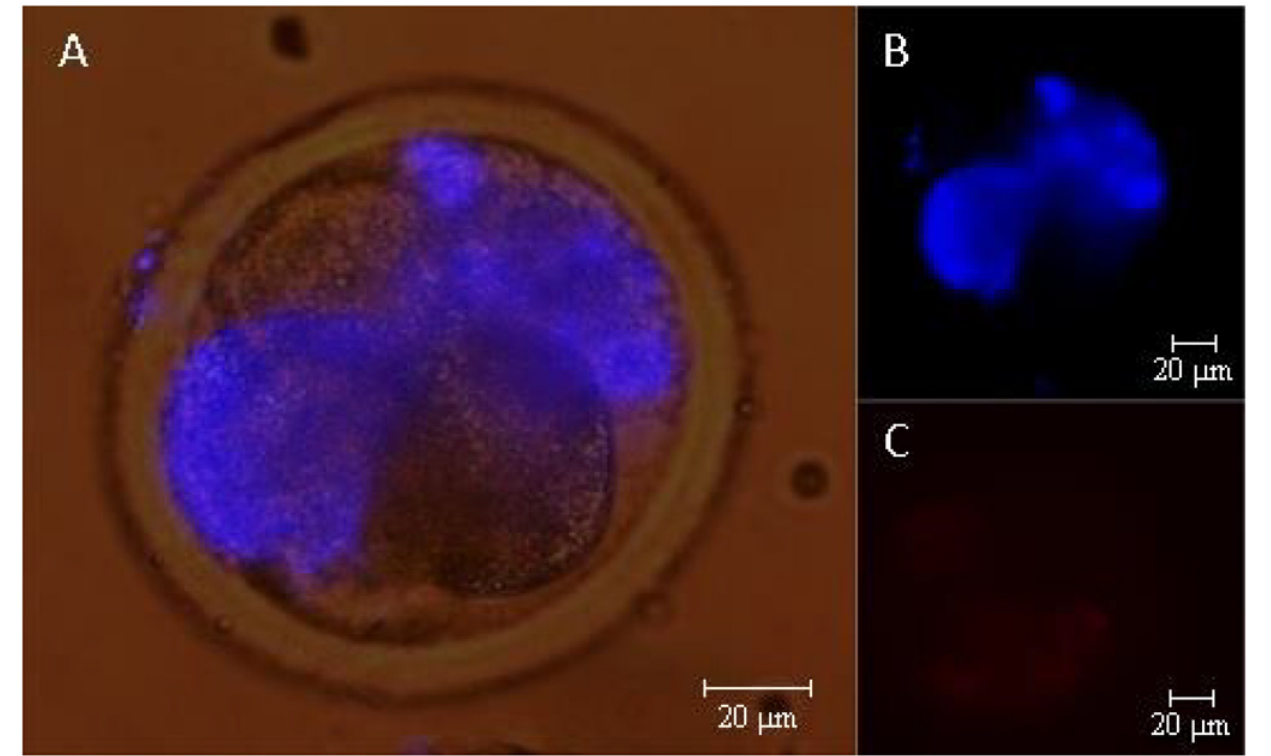
Fig 5. Annexin V staining. Epifluorescence photomicrography of embryos during the fourth cell cycle at 48 hpi: A) embryo with blastomeres undergoing apoptosis; B) blastomeres with blue staining indicating a positive reaction to the Annexin V antibody; and C) blastomeres without membrane permeability to propidium